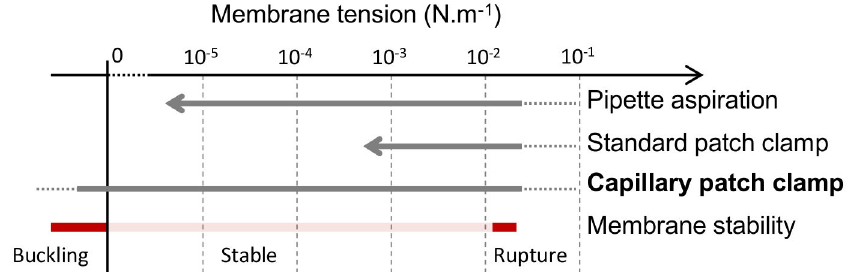
Figure 8. Range of accessible membrane tension. Schematic description of the accessible membrane tension range for the pipette aspiration technique, for standard patch clamp, and for our new capillary patch clamp method (if limiting glass adhesion surface). The typical regions where membranes are stable, buckling or breaking are shown in